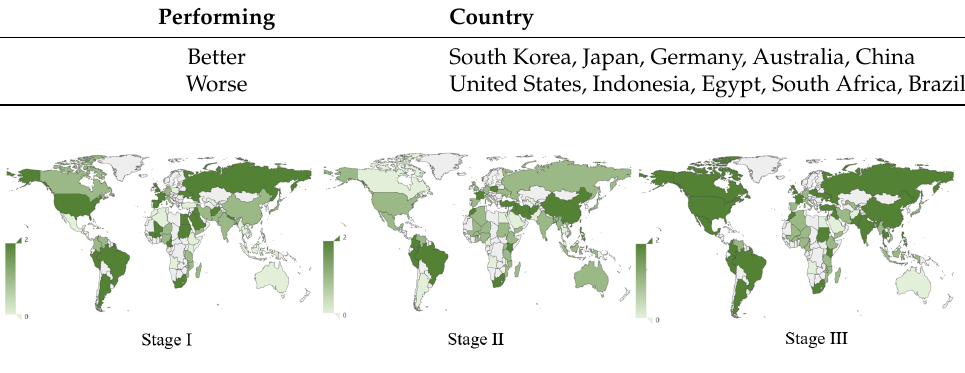
Figure 8. The performance score of countries in three